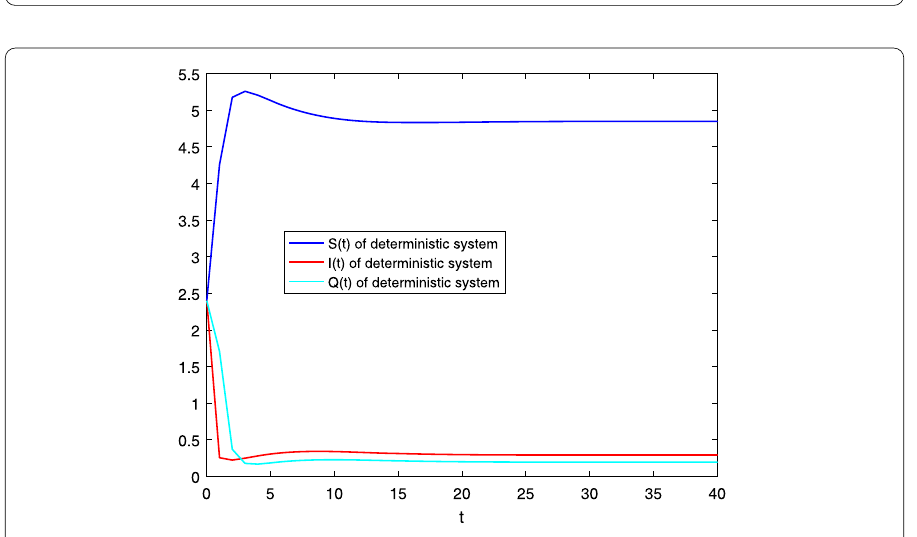
Figure 2 Time evolutions of deterministic system (2) with parameters u = 0.32, δ = 0.58, β = 0.3, b = 0.2, q = 0.26, ε = 0.32, α 2 = 0.12, α 3 = 0.23, γ = 0.25, m = 0.01, n = 0.5, A = 0.72, where R 0 = 1.3942 >